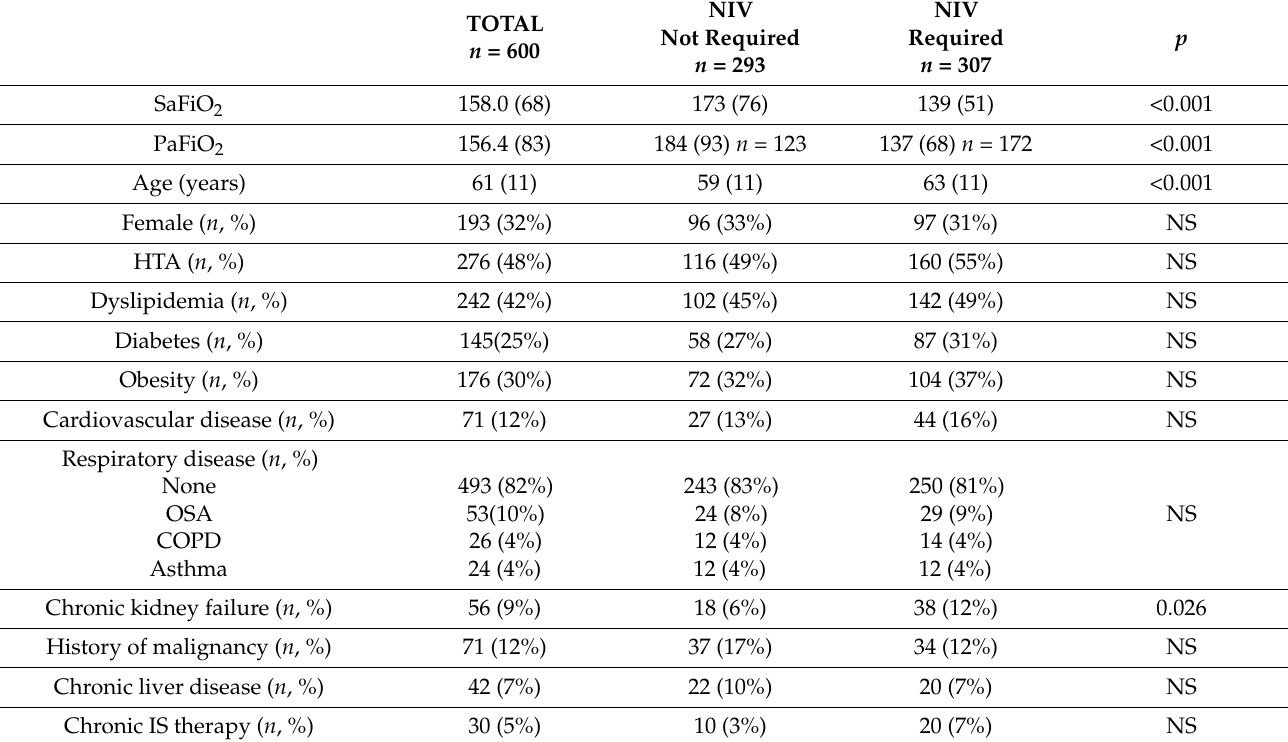
Table 1. Characteristics of the entire cohort and depending on NIV requirements. NIV, non-invasive ventilation; SaFiO 2 , oxygen saturation by pulse oximetry divided by inspired oxygen fraction; PaFiO 2 , partial arterial pressure of oxygen divided by inspired oxygen fraction; HTA, arterial systemic hypertension; OSA, obstructive sleep apnea; COPD, chronic obstructive pulmonary disease; IS therapy, immunosuppressive therapy; IRCU, intermediate respiratory care unit; ICU, intensive care unit; OT, oral intubation; RR, respiratory rate; PaCO 2 , partial arterial pressure of carbon dioxide; LDH, lactate dehydrogenase; NRT, non-invasive respiratory therapy; HFNC, high flow nasal cannula; FiO 2 , inspired oxygen fraction; H + T, bolus and progressive